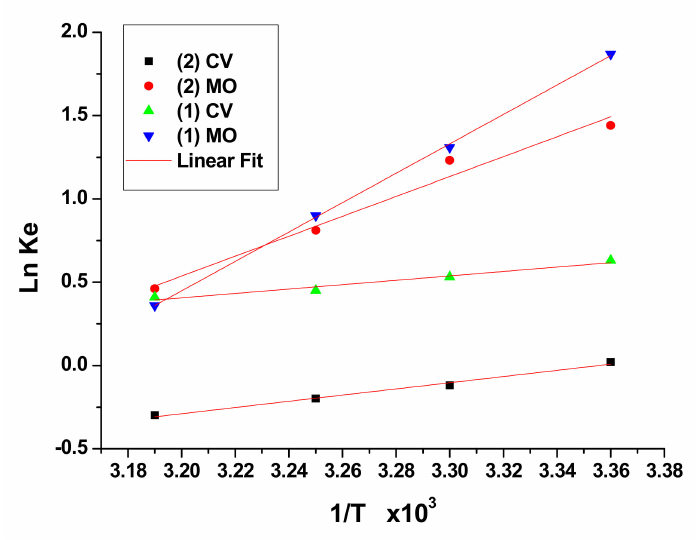
Figure 13. Van’t Hoff plot of Ln Ke vs. 1/T for the adsorption of MO or CV dye (100 mg/L) by 0.01 g of (1) or (2) materials. (Volume of dye solution = 10